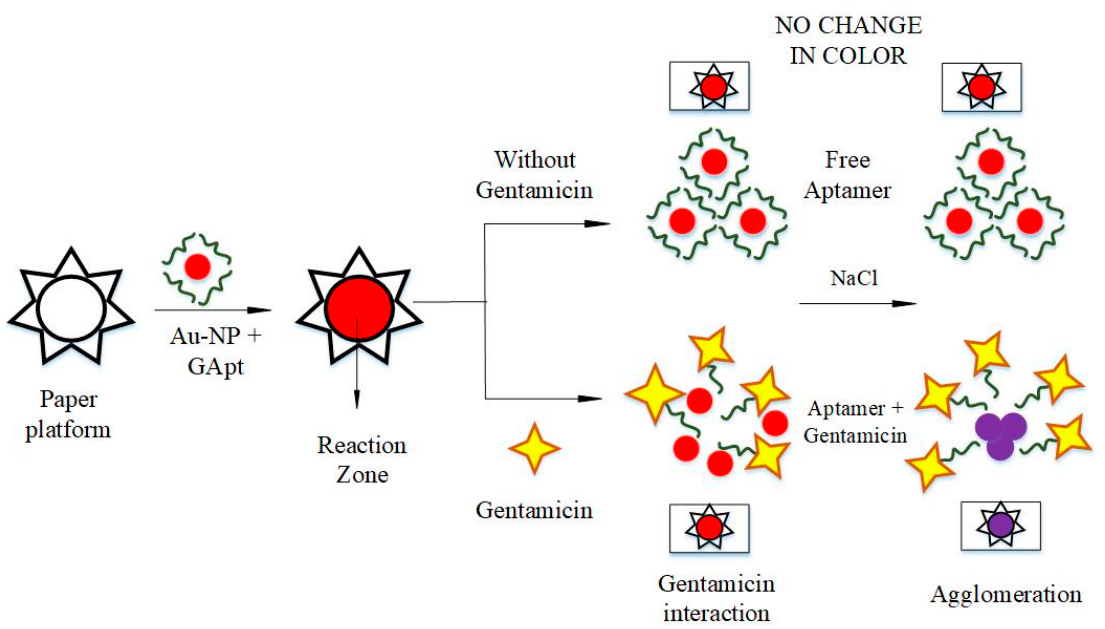
Figure 3. Schematic representation of the working of the prepared paper biosensor, which uses a colorimetric detection approach for gentamicin.